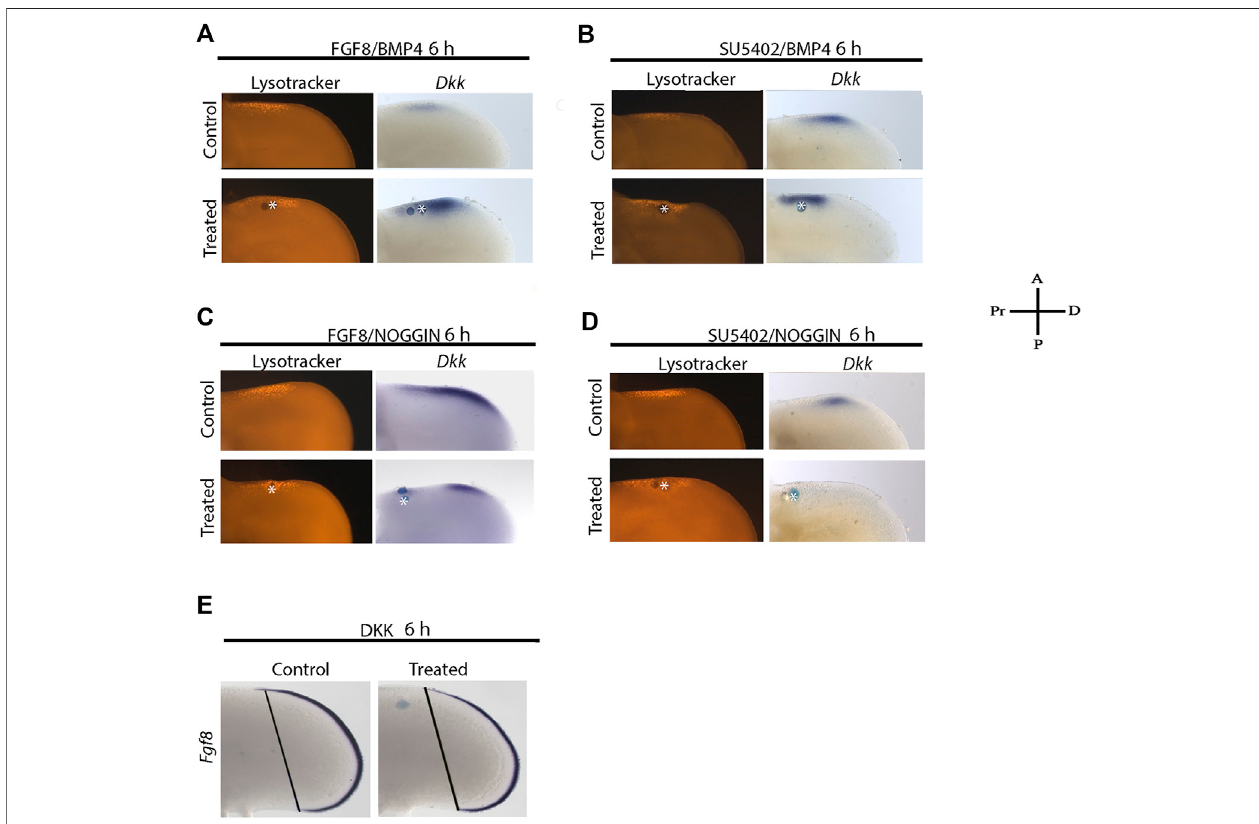
FIGURE 6 | The last step to induce cell death is the inhibition of FGF signaling.Double treatments were done to promote or block FGF and BMP signaling for 6 h. Under these conditions, lysotracker staining and Dkk gene expression were evaluated. (A) Double FGF8 and BMP4 treatment promoted Dkk expression, and cell death wasobservedclosertotheBMPbead. (B) InhibitingFGFsignalinginthepresenceofBMP4, Dkk wasstillexpressed. (C) TreatmentwithNOGGINandinthepresenceof FGF8 signi fi cantly inhibited Dkk expression, but it slightly diminished the area of cell death. (D) Double treatment inhibiting FGF and BMP signaling inhibited Dkk gene expression, but no cell death. (E) Fgf8 gene expression is inhibited in response to DKK protein. Notice that the blue line of the right limb (DKK treatment) — representing the expression of Fgf8 from the limb posterior margin to the anterior limb margin — is shorter than the contralateral limb.